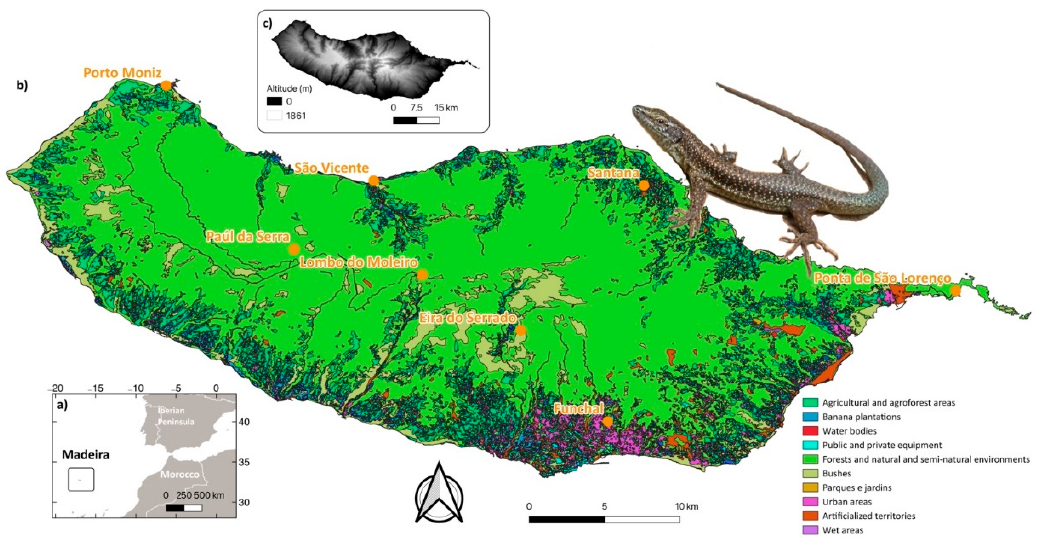
Figure 1. Map depicting the geographic location of Madeira Island ( a ), and the eight sampled populations across different habitats ( b ): Funchal (311 m.s.l.), Eira do Serrado (1051 m.s.l.), Lombo do Moleiro (1000 m.s.l.), Paúl da Serra (1446 m.s.l.), Ponta de São Lourenço (61 m.s.l.), Porto Moniz (38 m.s.l.), Santana (420 m.s.l.), and São Vicente (1 m.s.l.). A topographical map is also represented ( c ).